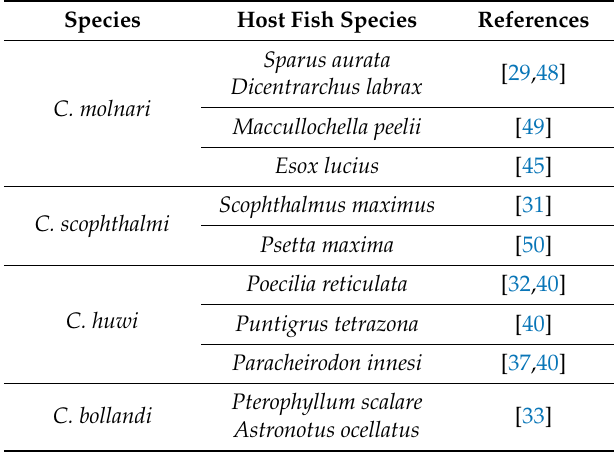
Table 2. Fish-specific Cryptosporidium species and their hosts.